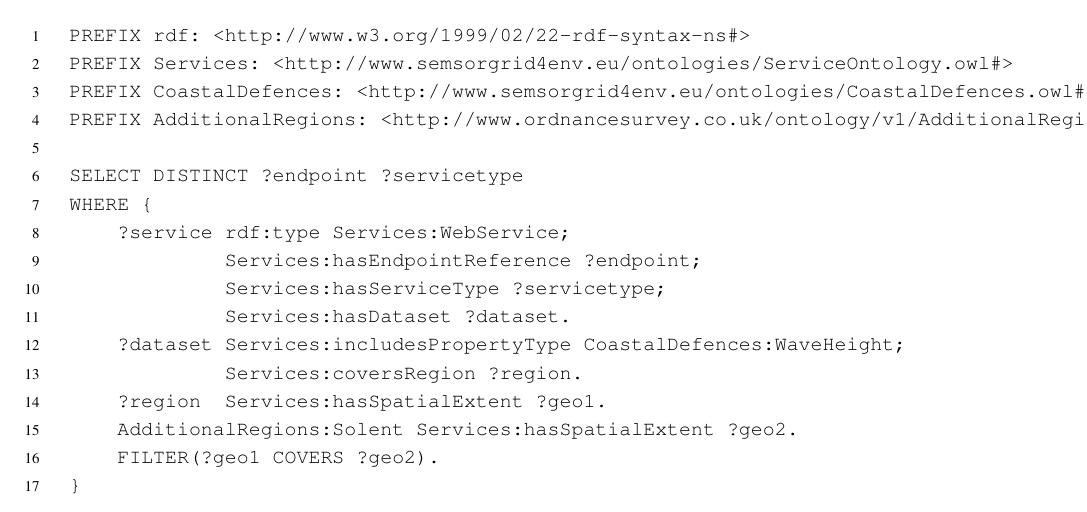
Figure 4. Declarative query to the Strabon registry service in the st SPARQL language. The query discovers service endpoints and their type for data sources providing wave height measurements for the Solent